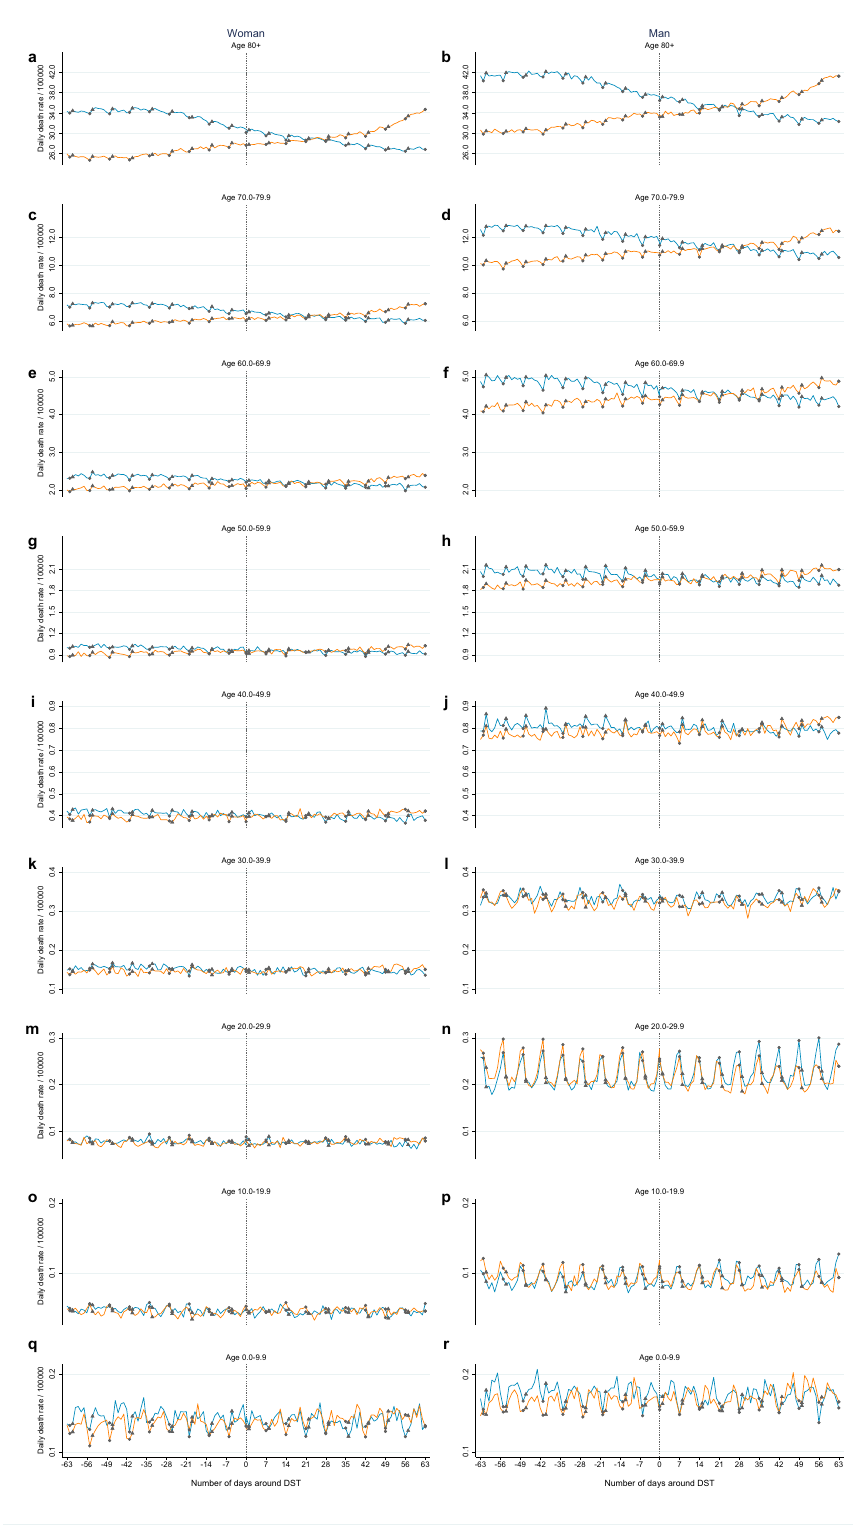
Fig. 2 | Unadjusted average daily death rate by sex and age groups. Unadjusted average dailydeath rate/100,000observedbetween1998and 2012in 16 European countries by sex (women (left); men (right)) and 10 years age groups 80+ ( a , b ), 70.0 – 79.9 ( c , d ),60.0 – 69.9 ( e , f ), 50.0-59.9 ( g , h ),40.0 – 49.9 ( i , j ), 30.0 – 39.9 ( k , l ),